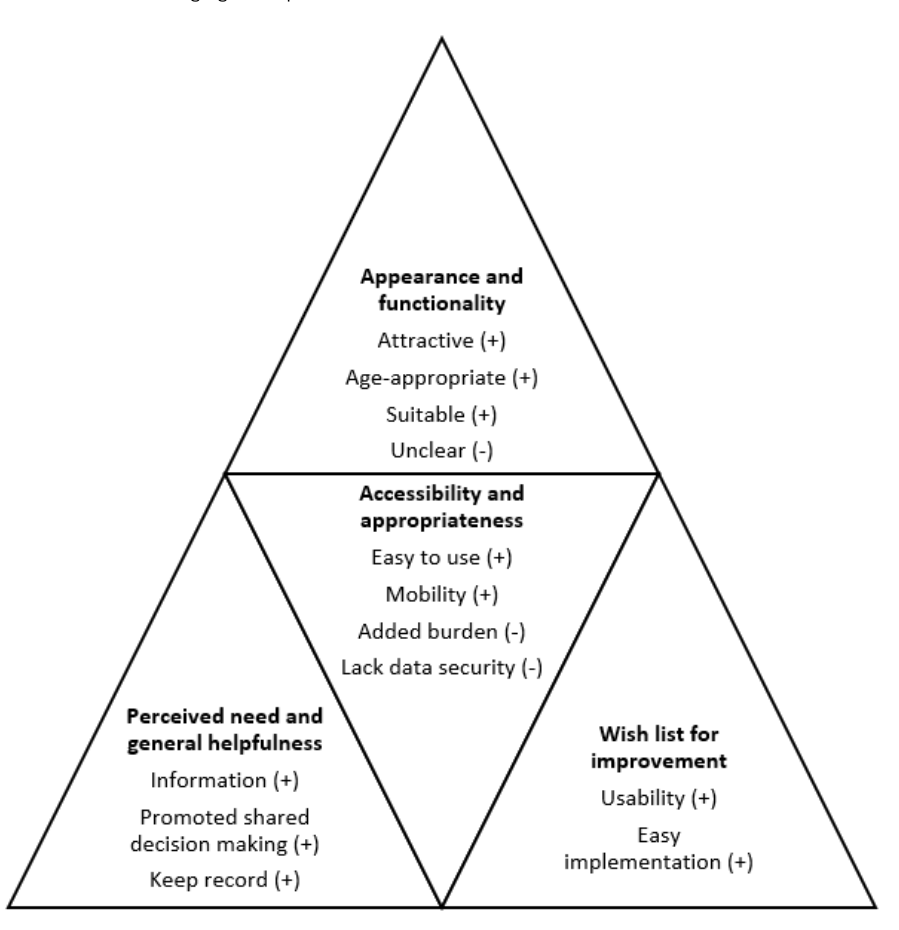
Figure 2. An overview of the themes emerging from qualitative